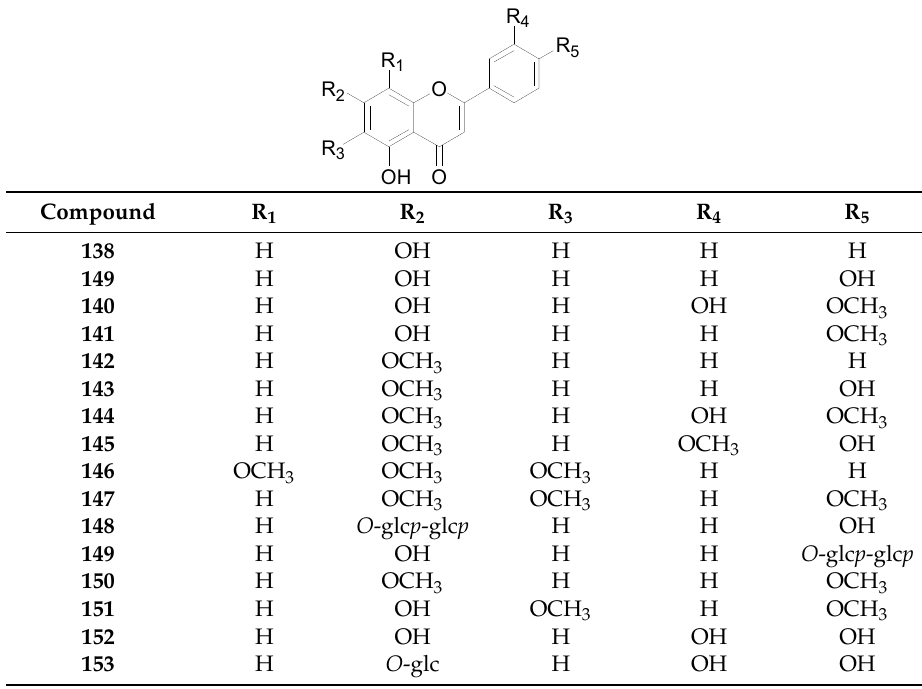
Table 9. Structures of compounds 138 – 153 .